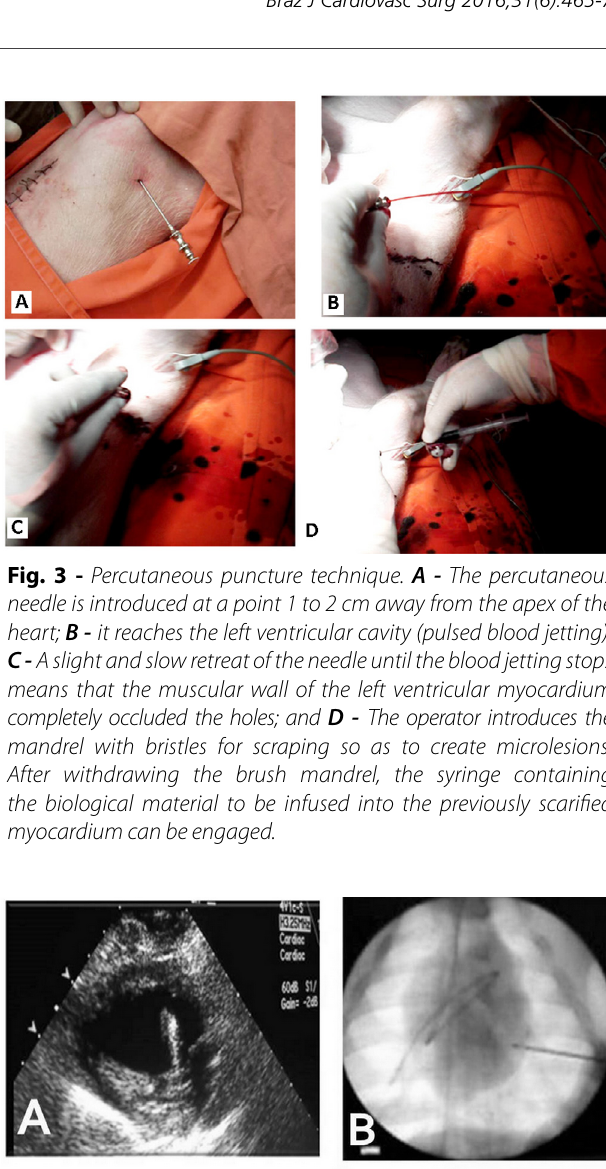
Fig. 4 - The instrument is easily visualized. A – Echocardiography; B –